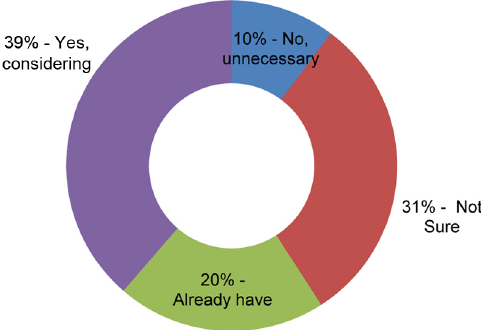
Figure 19. SMEs ’ level of